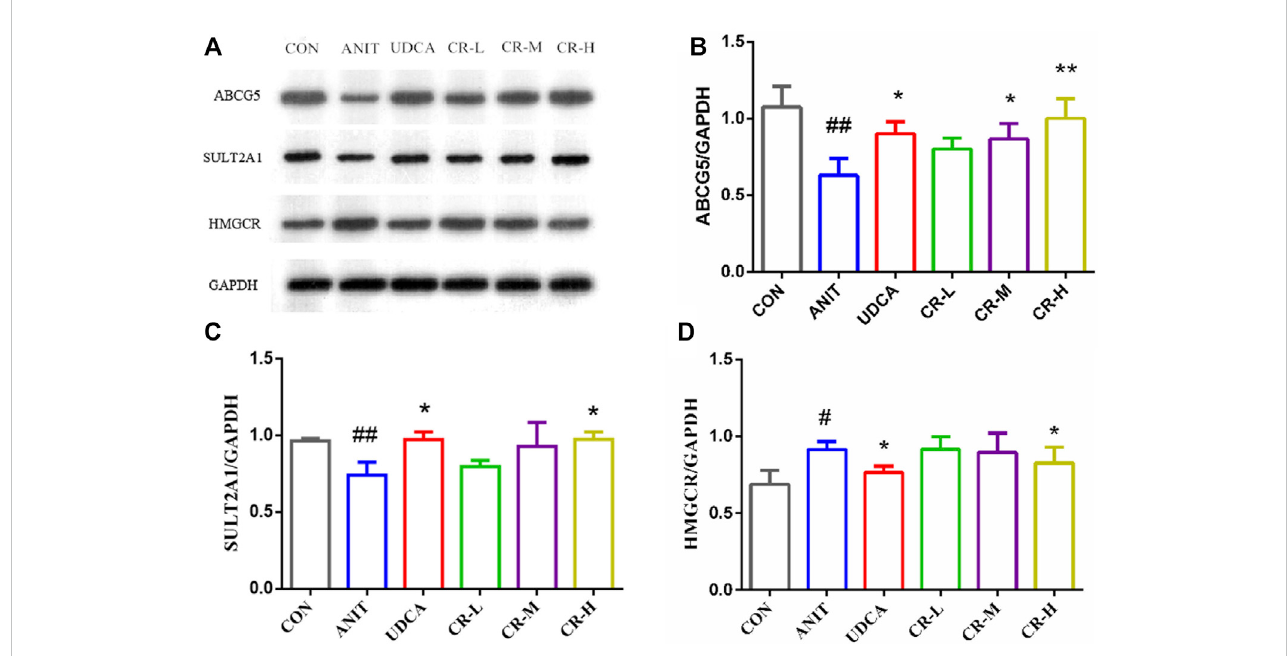
FIGURE 10 Expression levelsofdifferentproteinsinthelivertissueofratsafteradministration. (A) Electrophoreticdiagramofdifferentgroups, (B) expressionlevelof ABCG5 protein, (C) expression level of SULT2A1 protein, (D) expression level of HMGCR